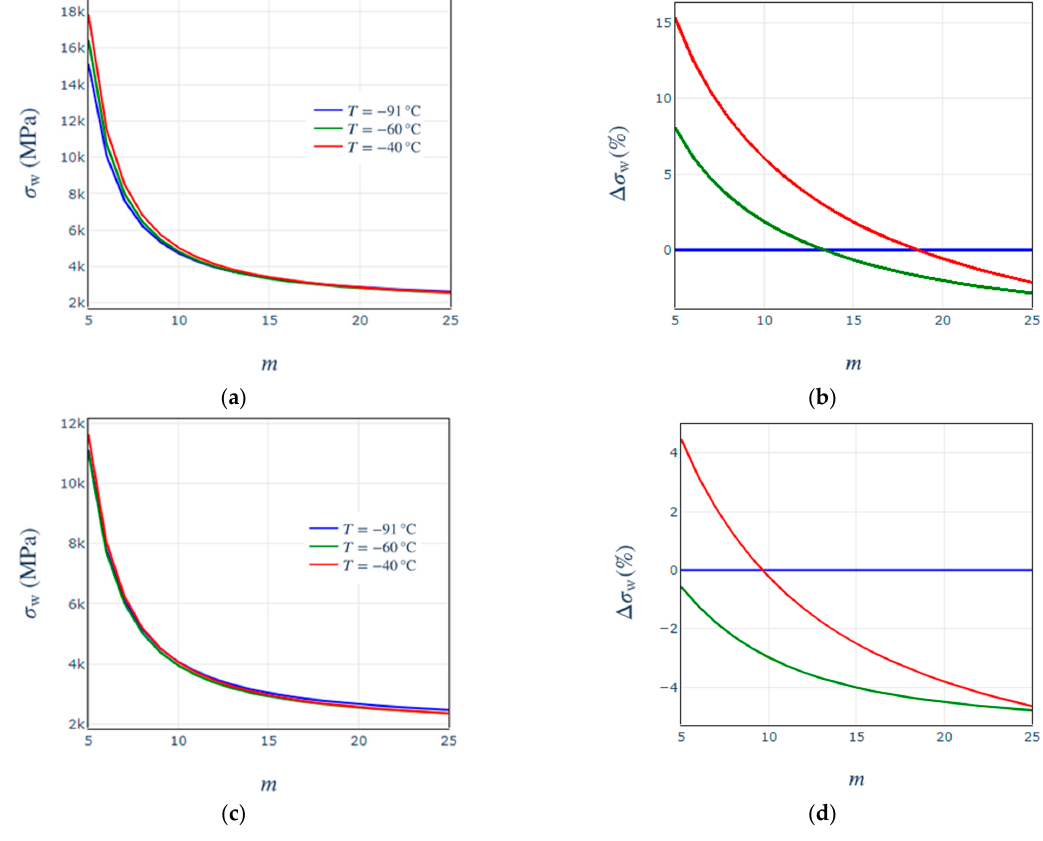
Figure 5. ( a ) Weibull stress and ( b ) Weibull stress difference in percentage with respect to the Weibull stress at − 91 °C, using the original Beremin model as a function of the shape parameter 𝑚 ; ( c ) Weibull stress and ( d ) Weibull stress difference in percentage with respect to the Weibull stress at − 91 °C, using the developed model as a function of the shape parameter 𝑚 .